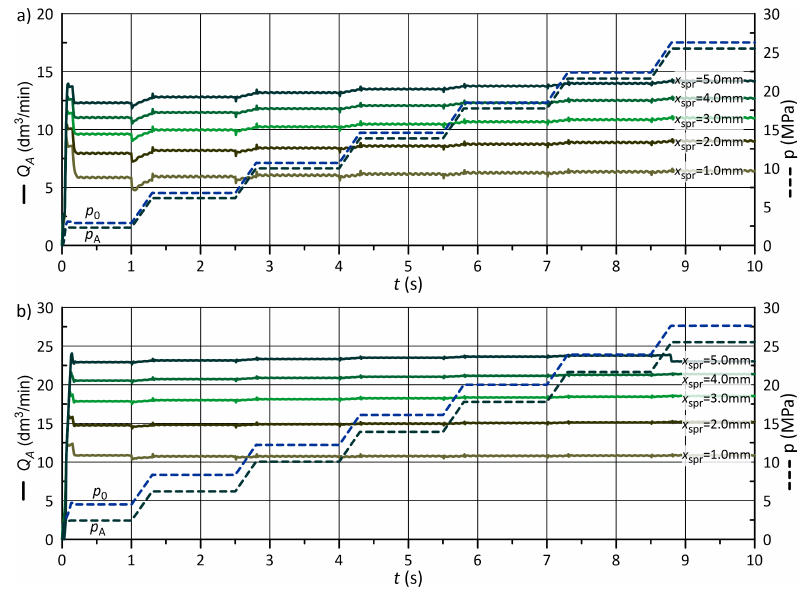
Figure 14. Valve flow rate obtained with stepwise changes in load line pressure: ( a ) soft spring ( k spr = 10N mm − 1 ), ( b ) rigid spring ( k spr = 40N mm − 1 ).